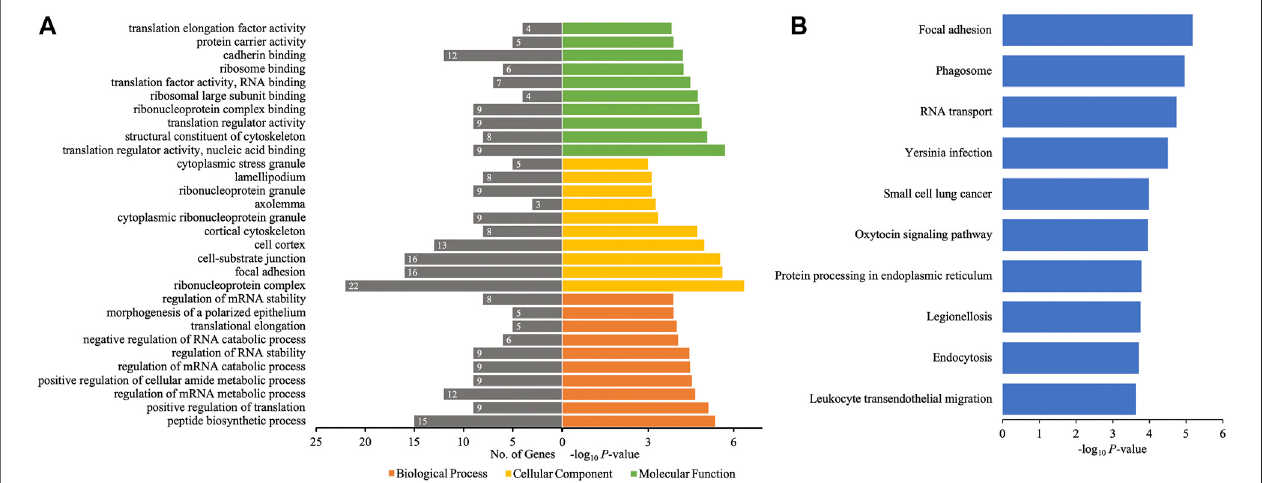
FIGURE4| GOannotationsandKEGGpathwayanalysesforhostgenesofthedifferentiallyquanti fi edcircRNAs. (A) GOannotations.TheGOanalysiscategorized themRNAsintodifferentgroupsunderthethemeofbiologicalprocess,cellularcomponent,andmolecularfunction.ThegenecountforeachGOcategoryislistedonthe left. (B) Top 10 KEGG pathways. The vertical axis indicates the pathway category, and the horizontal axis indicates the − log 10 p -value of a pathway (Fisher ’ s exact